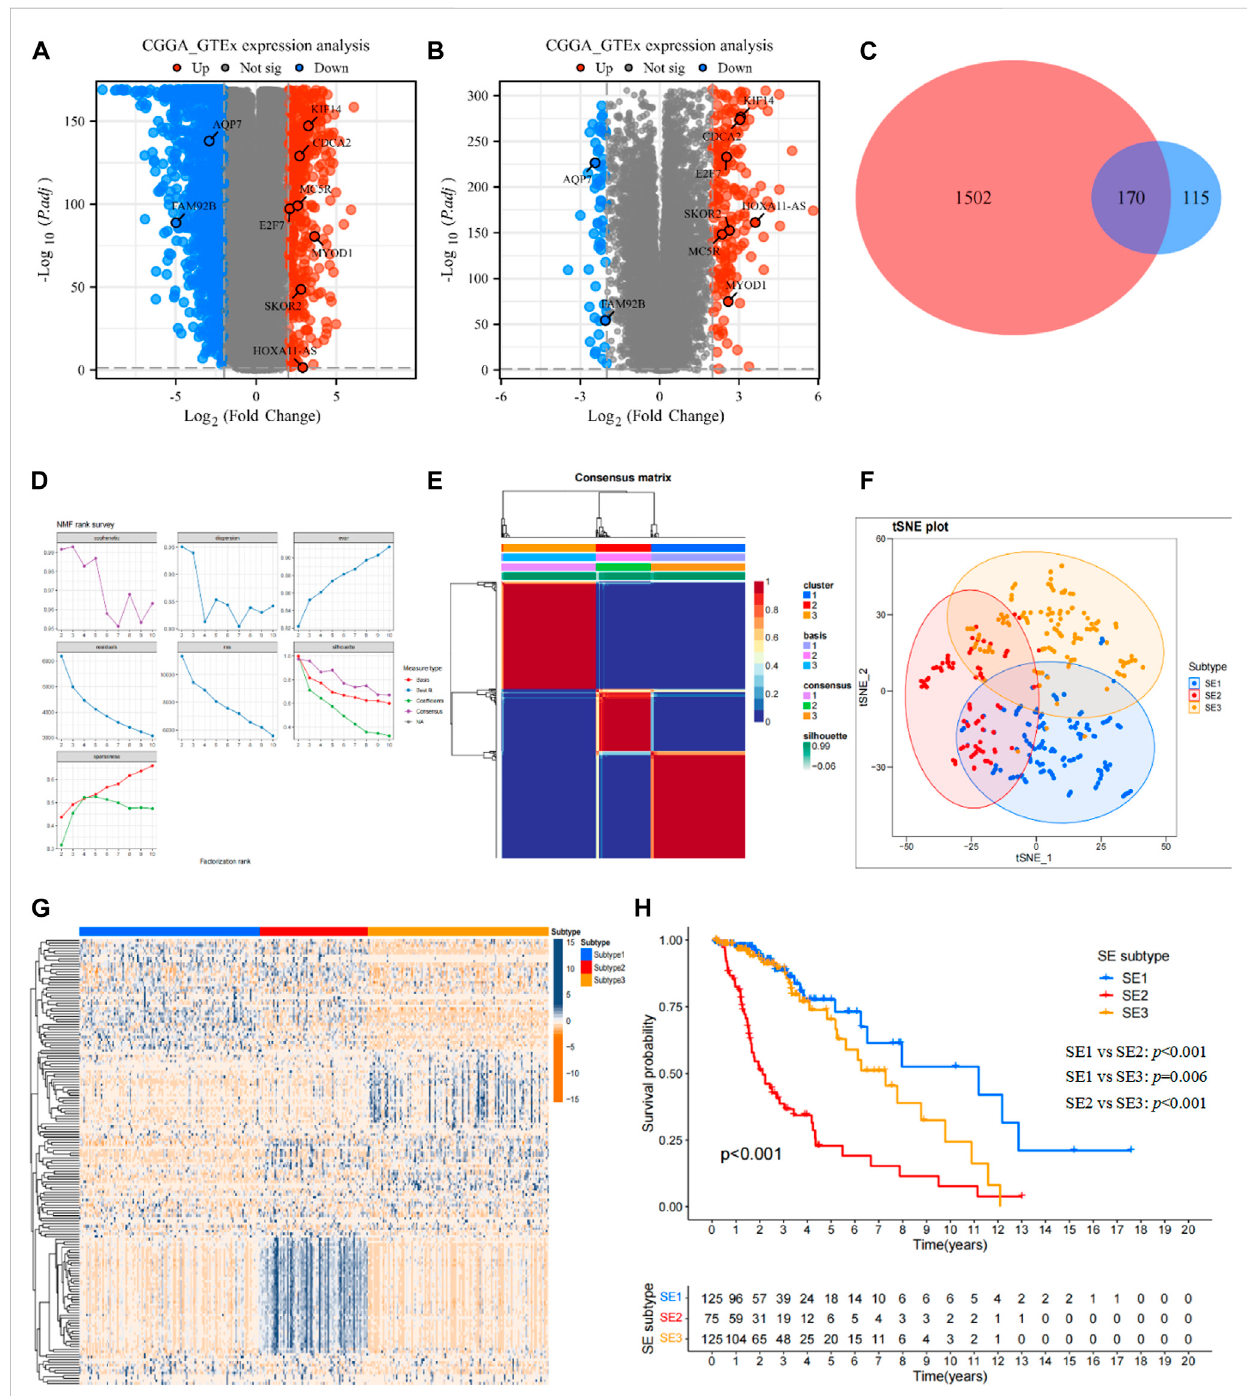
FIGURE 2 Identi fi cationofSEsubtypesofLGGbyusingNMFalgorithm. (A) VolcanoplotshowedDEGs( p < 0.05and|log2FC| > 2)betweenLGGtissuesinTCGA cohort and normal brain tissues in GTEx database. (B) Volcano plot showed DEGs ( p < 0.05 and |log2FC| > 2) between LGG tissues in CGGA cohort and normal brain tissues in GTEx database. (C) Venn diagram identi fi ed prognostic super-enhancer related DEGs. (D) The NMF rank survey of TCGA cohort using theSE-related DEGs. (E) Consensus map of NMF clustering. (F) tSNE plot of 170 SE-related DEGs to distinguish SE subtypes. (G) Heatmap showed the expression levels of 170 SE-related DEGs among SE subtypes. (H) Kaplan – Meier survival analysis exhibited signi fi cantly different OS among three SE